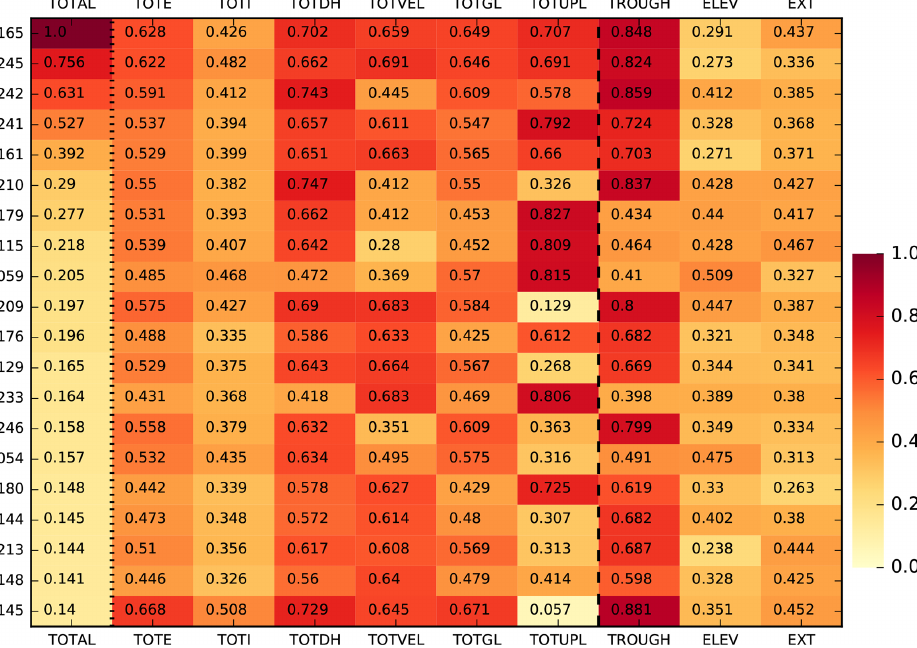
Figure 2. Aggregated scores and nine individual scores for 20 best ensemble members computed versus modern and geologic datasets, divided by dashed line. The score values are normalized by the median misfit and range from 0 (bright yellow – no skill) to 1 (dark red – best score) on a linear color scale. The standard deviation for the individual paleo-data-type scores ELEV and EXT, as well as for present-day ice shelf mismatch TOTI, is below 0.1. In contrast, grounding-line location at LGM and present day along four ice shelf basins (TROUGH) and present-day uplift rates (TOTUPL) have the strongest impacts on the aggregated score, with a standard deviation of 0.2 and 0.3, respectively. Intermediate variability in individual scores show TOTGL, TOTE, TOTDH and TOTVEL with a standard deviation between 0.1 and 0.2. Table 1. Five best-score ensemble parameter combinations with parameter values and total scores. The best-fit simulation parameters (bold) were used in the initMIP-Antarctica model intercomparison (PISMPAL3; Seroussi et al., 2019) and for the reference simulation in the companion paper (Albrecht et al., 2020). Simulation Normal